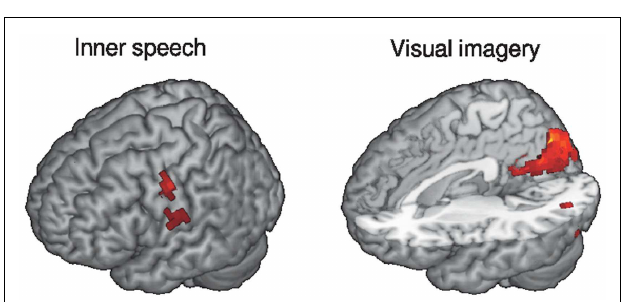
FIGURE 4 | Rendering of brain regions with mean BOLD activity (relative to wakefulness) during N2 sleep correlating with the reported level of inner speech/visual imagery experienced during the fMRI session (thresholded at z > 3) . Subjective reports were collected retrospectively immediately after the fMRI session. fMRI data correspond to the same subjects reported inTagliazucchi et al.